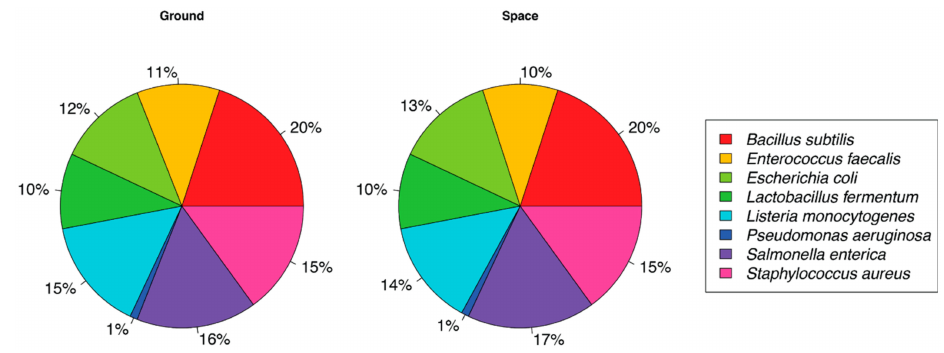
Figure 1. Percentage of reads assigned to ZymoBIOMICS Microbial Community DNA Standard reference genomes based on alignment using minimap2 (-ax map-ont). The space nanopore